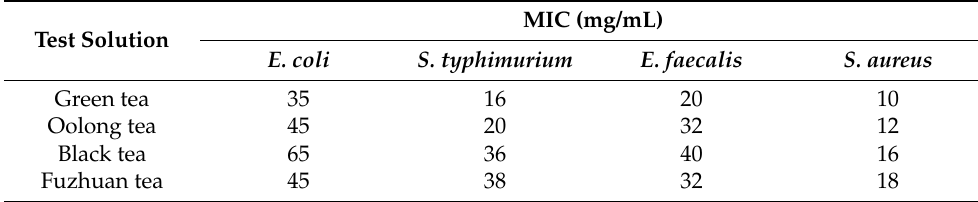
Table 2. MIC of tea extracts against tested